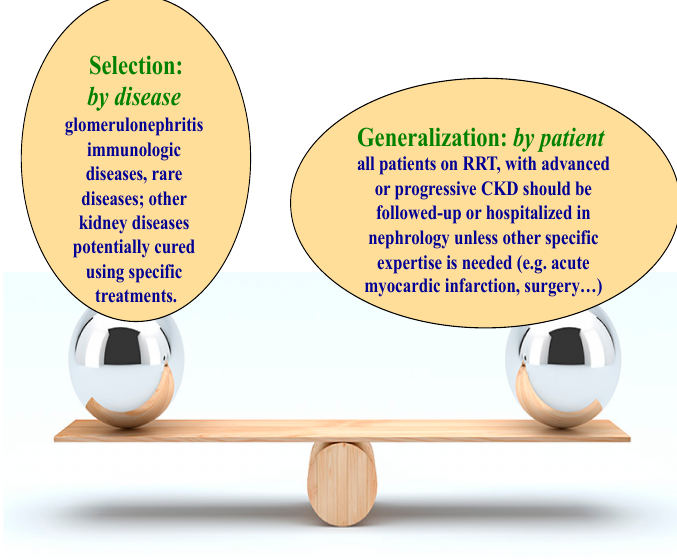
Figure 6. Paradoxes in care. The example of hospitalisation: should we focus on diseases or on patients?